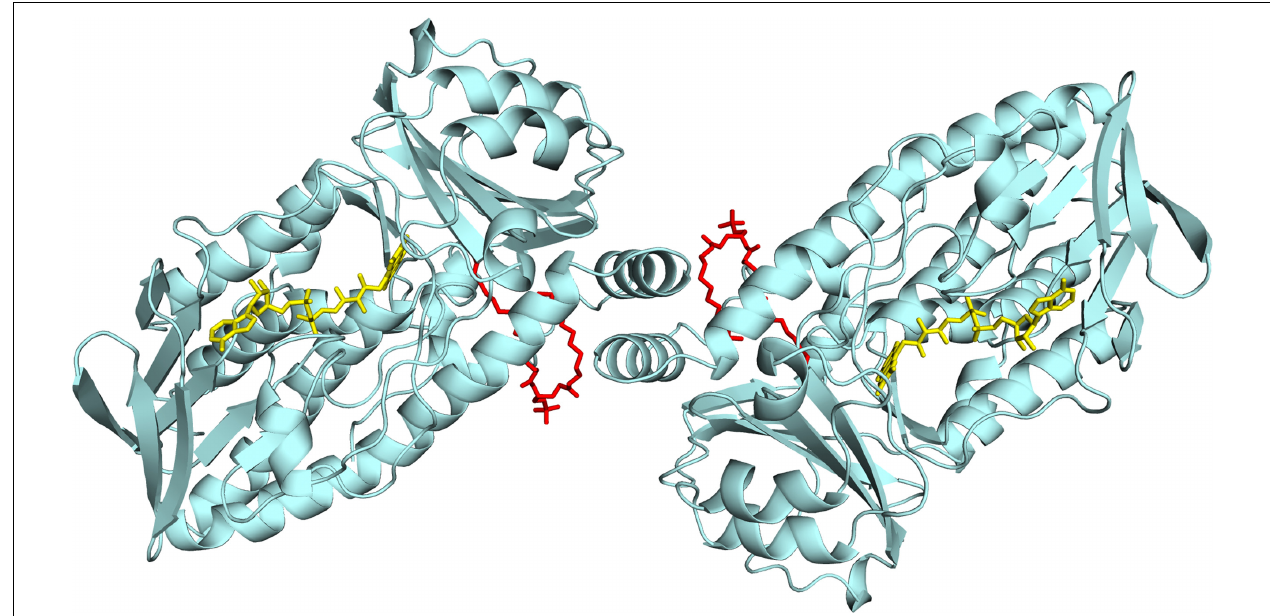
FIGURE 1 | Lipid binding in 3HB6H from R. jostii RHA1. Cartoon of the three-dimensional structure of the 3HB6H dimer (Montersino et al., 2013). The protein is shown in light blue and the FAD cofactor is depicted as stick model in yellow. The lipid cofactor and the aromatic substrate are shown as stick models in red and dark blue, respectively.